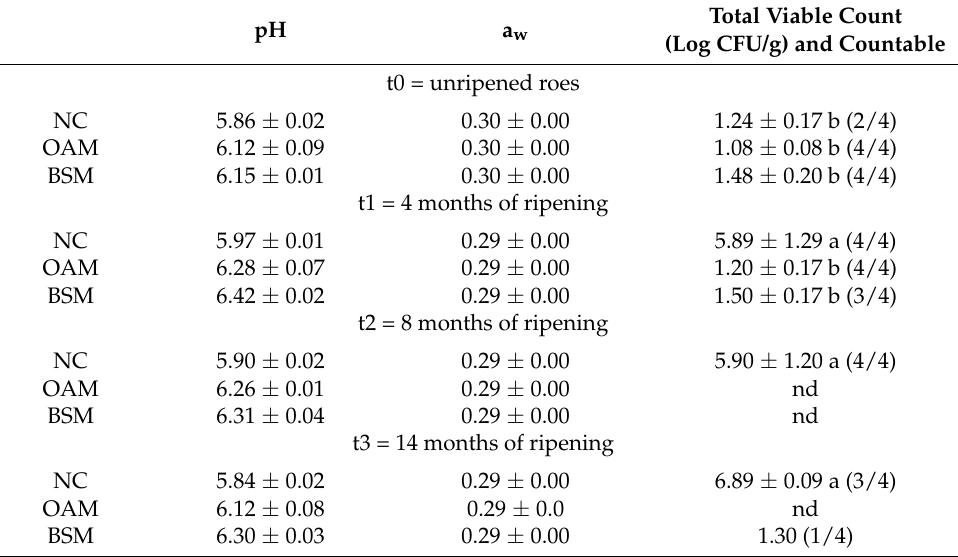
Table 2. pH, a w , and total viable count (TVC, expressed as Log CFU/g) detected in caviar under investigation during the ripening time. Data were expressed as mean ± SEM (standard error of the mean). For the TVC, the number of samples in which counts were detected is indicated in brackets. Legend: NC, sodium chloride (NaCl); OAM, organic acid mixture; BSM, borax and salt mixture. a w : water activity, TVC: total viable counts. Total Viable Count pH a w (Log CFU/g) and Countable t0 = unripened roes NC 5.86 ±